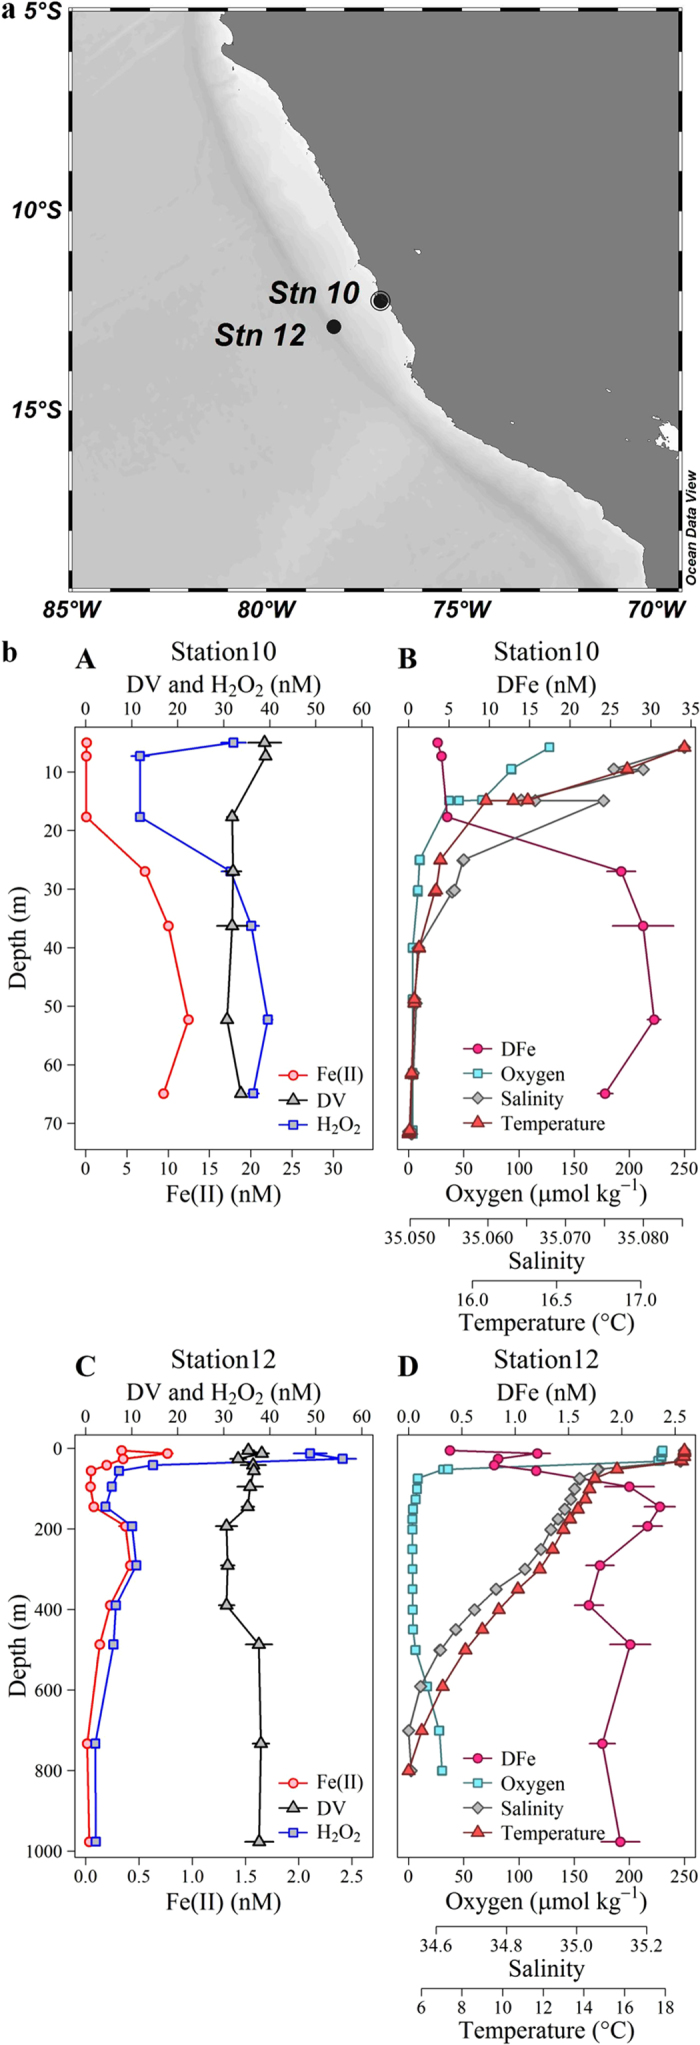
(a) Location of a shallow (Station 10) and offshore (Station 12) station within the Peruvian oxygen minimum zone (OMZ), plotted in Ocean Data View54. (b) H2O2 concentrations (after deduction of an aged seawater blank) and concentrations of potentially interfering trace metals at two stations in the OMZ. A Station 10 H2O2, dissolved (<0.2 μm) V (DV), Fe(II). B Station 10 Salinity, temperature, dissolved Fe (DFe), dissolved O2. C Station 12 H2O2, DV, Fe(II). D Station 12 Salinity, temperature, DFe, dissolved O2. (b) made in R version 3.2.3 (2015), GWDG Göttingen, Germany, http://ftp5.gwdg.de/pub/misc/cran/.